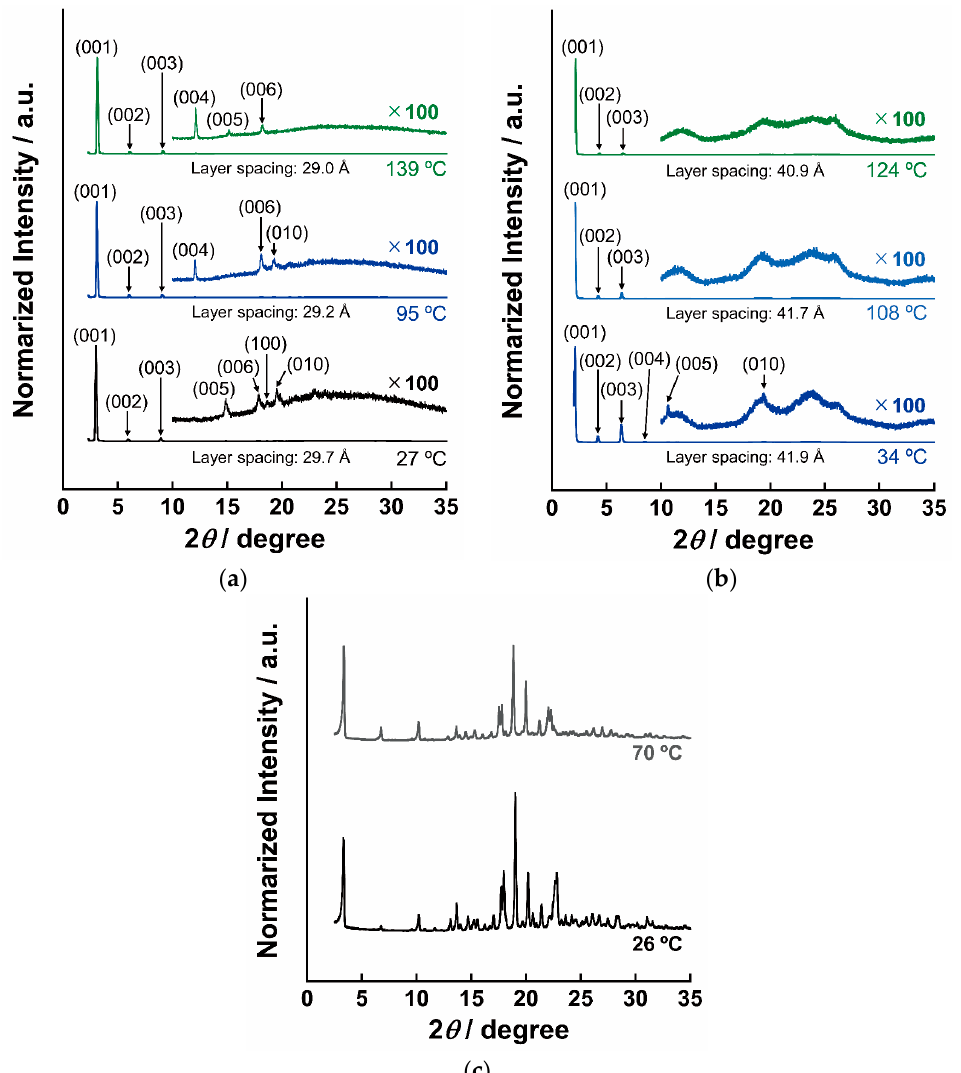
Figure 6. Variable-temperature XRD profiles of ( a ) ( R )- 1 , ( b ) ( R )- 2 , and ( c ) ( R )- 3 . The XRD pattern of the LC phase of ( R )- 2 at 124 °C (Figure 6b, upper) exhibits several peaks at 2 θ = 2.16°, 4.36°, and 6.49°. These three peaks are attributed to the (001), (002), and (003) planes with diffractions derived from the periodicity of the smectic-layer struc- ture. Although the extended molecular length of ( R )- 2 is estimated to be 38 Å by MM2 calculations, the experimentally obtained layer spacing is 41 Å. The layer spacing is greater than the theoretical molecular length that an interdigitated layer structure can achieve. The halos observed at approximately 2 θ = 12°, 20°, 24°, and 26° also confirm the